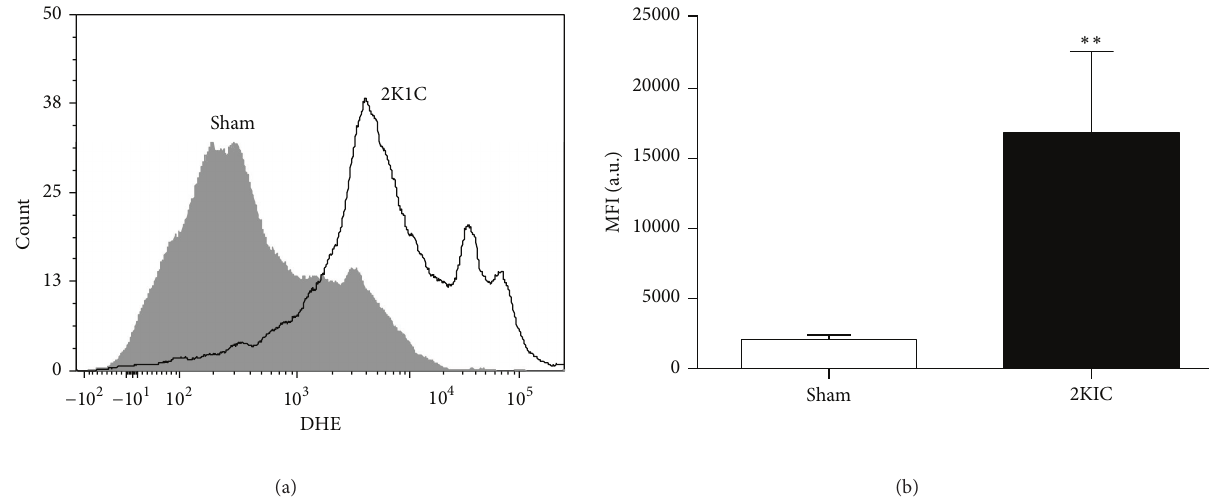
Figure 4: Effects of renovascular hypertension on oxidative stress in bone-marrow-mononuclear cells (BM-MNCs). (a) contains representative histograms of intracellular oxidation of dihydroethidium (DHE) to ethidium by BM-MNC from a hypertensive (2K1C) and a normotensive (Sham) mouse as evaluated by flow cytometry. The bar graph summarizes the median fluorescence intensity (MFI) values of DHE-loaded BM-MNC from 2K1C ( 𝑛 = 5 ) and Sham ( 𝑛 = 5 ) mice. Values are the medians ± coefficient of variation. ∗∗ 𝑃 < 0.01 versus the Sham group (Mann-Whitney